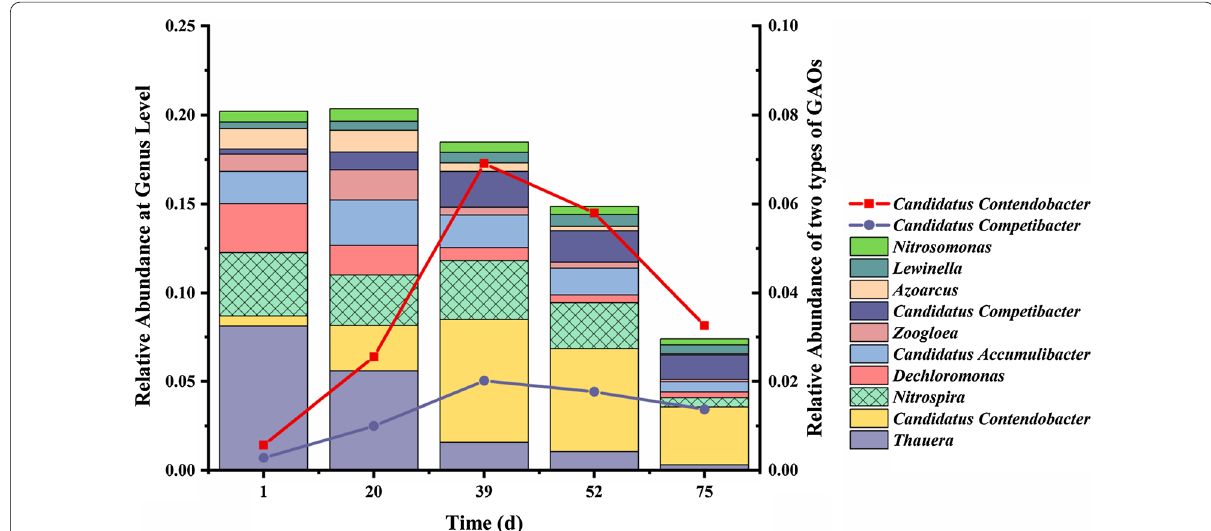
Fig. 3 The relative abundance of the microbial community and the dominant GAOs at genus level in the process of reactor